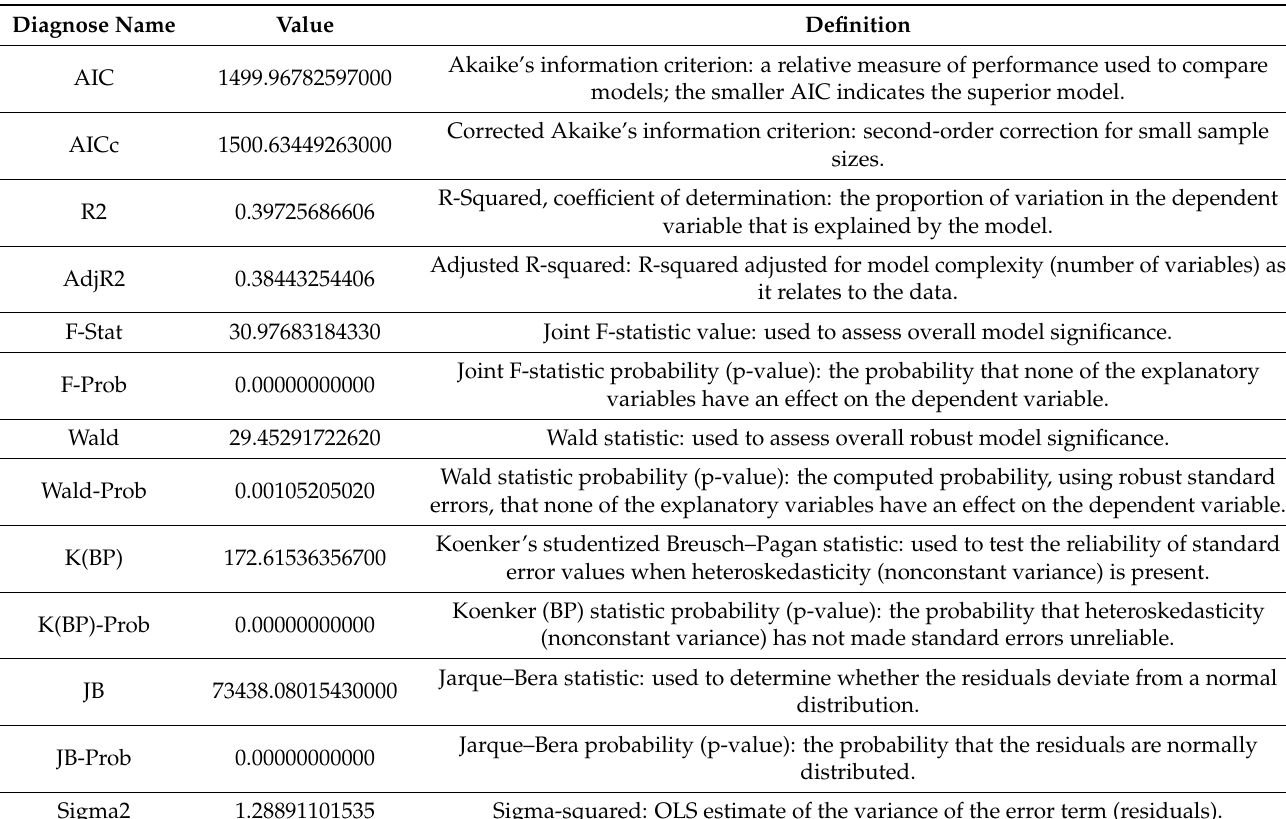
Figure A2. Spatial autocorrelation with GWR residuals. Table A4. Diagnostic information of GWR. Table A3. Diagnostic information of